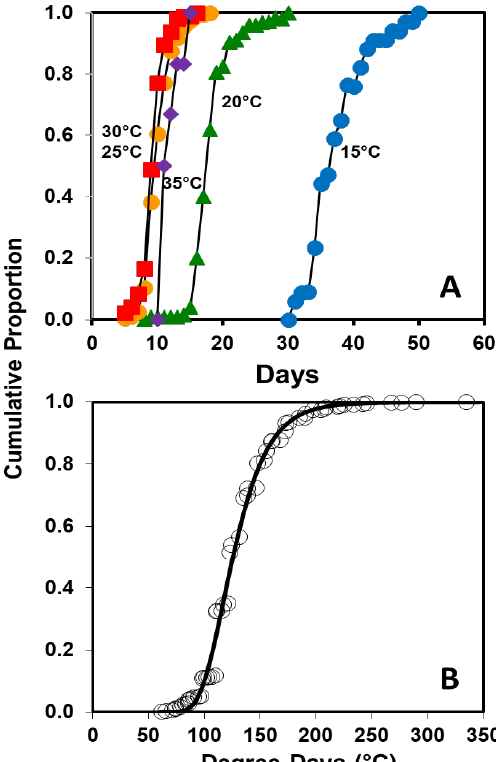
Figure 5. Observed cumulative frequency distributions for A. chinensis egg hatch times (d) at five constant temperatures (°C) ( A ). Cumulative proportion of A. chinensis eggs hatching over accumulated degree-days ( B ). The solid line in the bottom graph represents the fit to the equation: Predicted proportion hatching = exp (–exp (0.0469 ( ± 0.00139) X accumulated degree-days + 5.5186 (±0.1683))); adjusted R 2 = 0.994.